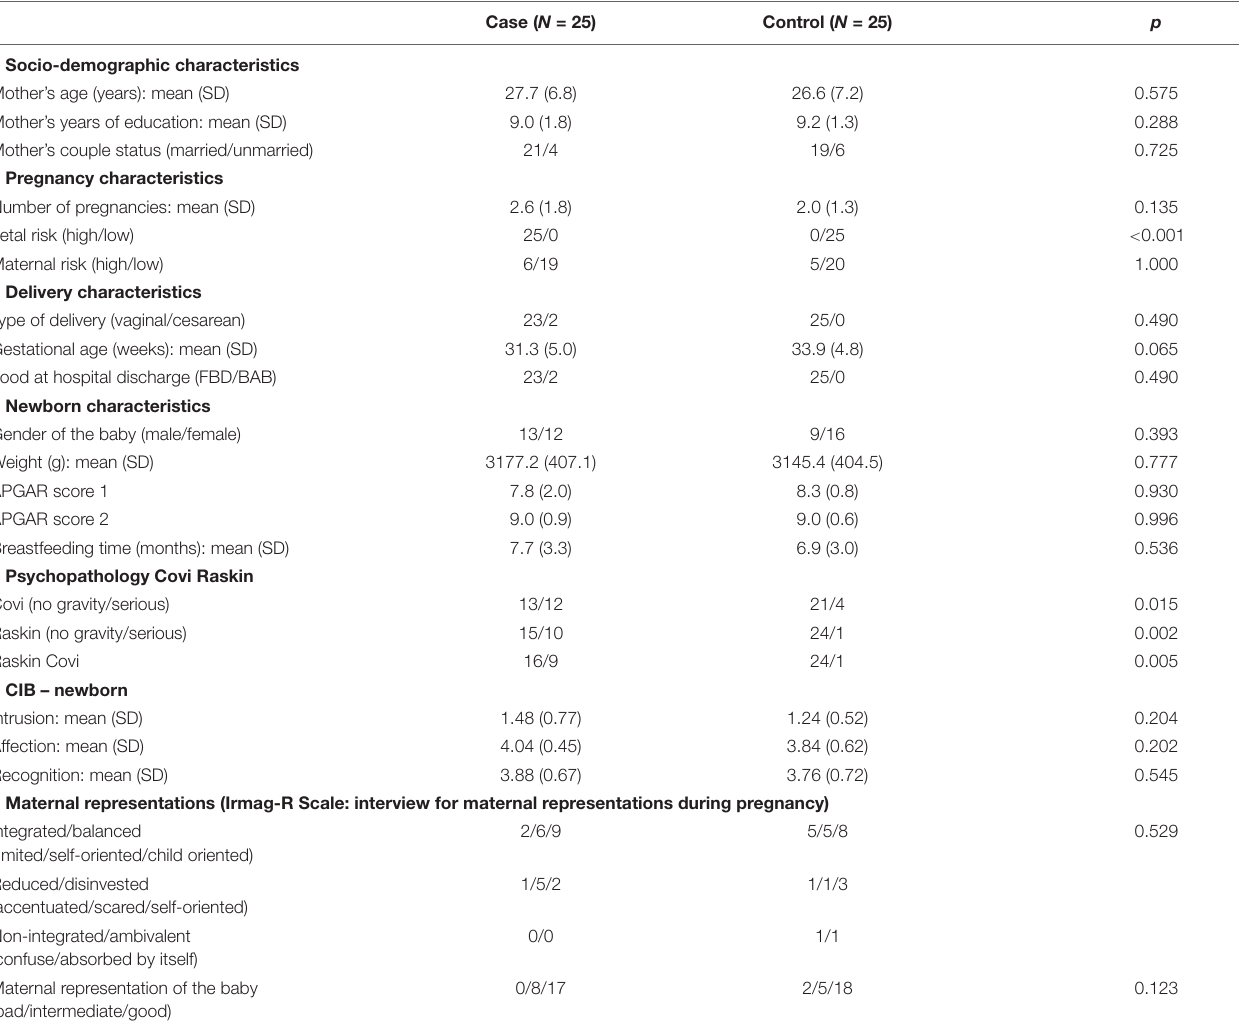
TABLE 1 | Demographic and clinical information for the mothers and